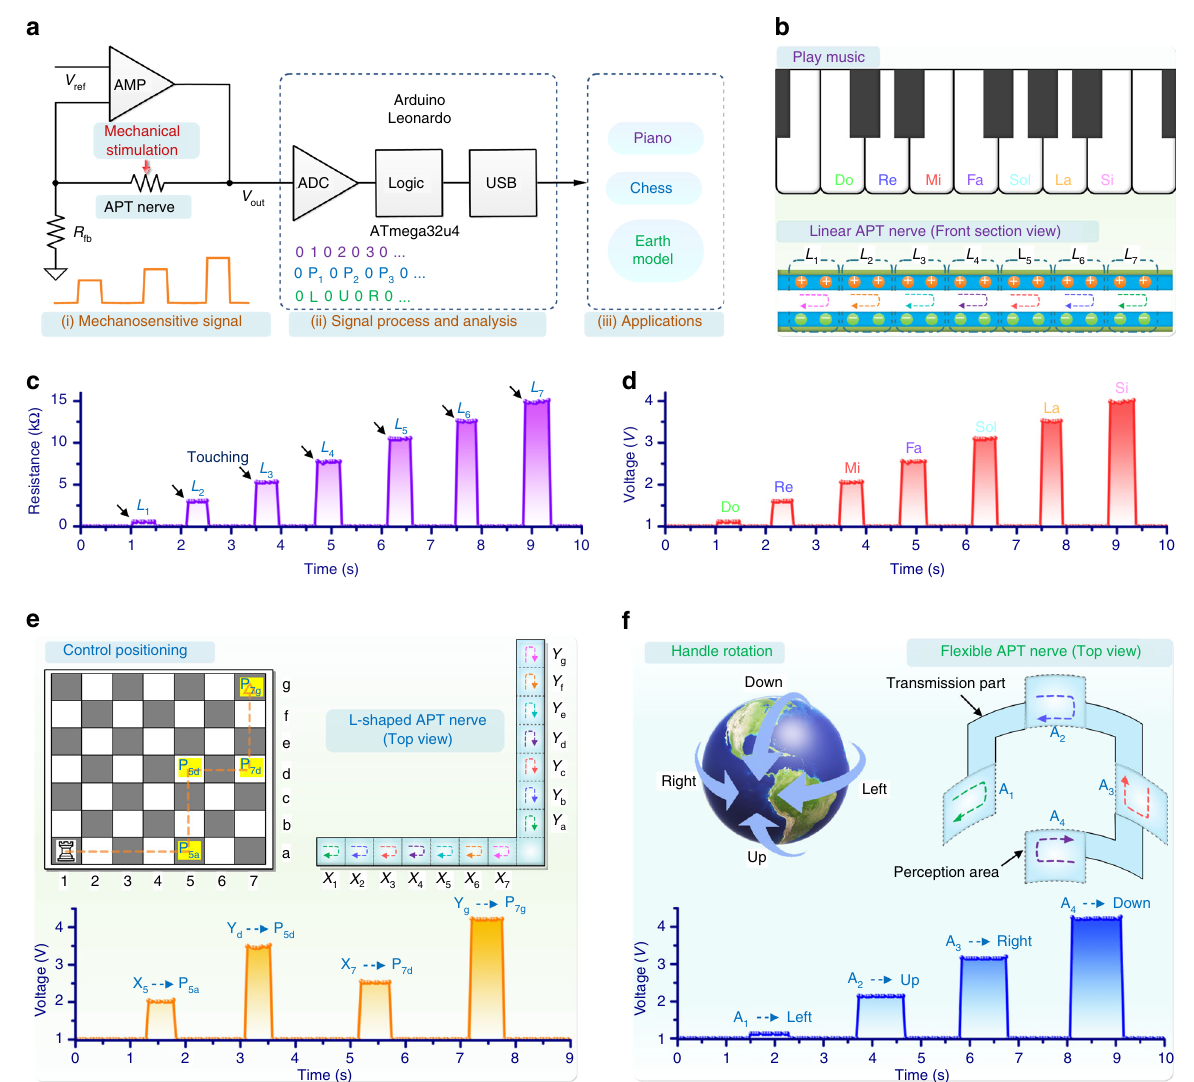
Fig. 3 Multifunctional touch interaction of the APT nerve. a Circuit schematic to drive the APT nerve for applications. b A linear APT nerve used for playing music. The tonic solfa of Do, Re, Mi, Fa, Sol, La, and Si would be produced by touching corresponding segments of the APT nerve. c Response resistance of the linear APT nerve when touching different segments. d Change in the voltage producing corresponding tonic solfa. e An L-shaped APT nerve used for controlling the position of a chess piece in a two-dimensional plane. The horizontal branch controlled the horizontal movement of the chess piece and the other branch controlled the movement of the chess piece on the vertical axis. Bottom: Change in the voltage when touching different segments. f Demonstration of handling the rotation of an earth model by using a fl exible APT nerve with a square shape. Each perception area was 10 × 10 mm 2 . Bottom: Touching different perception areas resulting in the changes in the (bottom of Fig. 3f). Thereupon, the earth model could be rotated up, down, left, and right by touching the corresponding perception area of A 2 , A 4 , A 1 , and A 3 . The response resistance of the fl exible APT nerve was generally stable by fi nger touch no matter it was in the fl at state or the bending state (Supplementary Fig. 10). Supplementary Movie 3 shows that we fi t the fl exible APT nerve on a bottle with a radius of ~2.7 cm to handle the rotation of the earth model. This result demonstrated the proposed APT nerve featured fl exibility that was similar to the biological nerve.